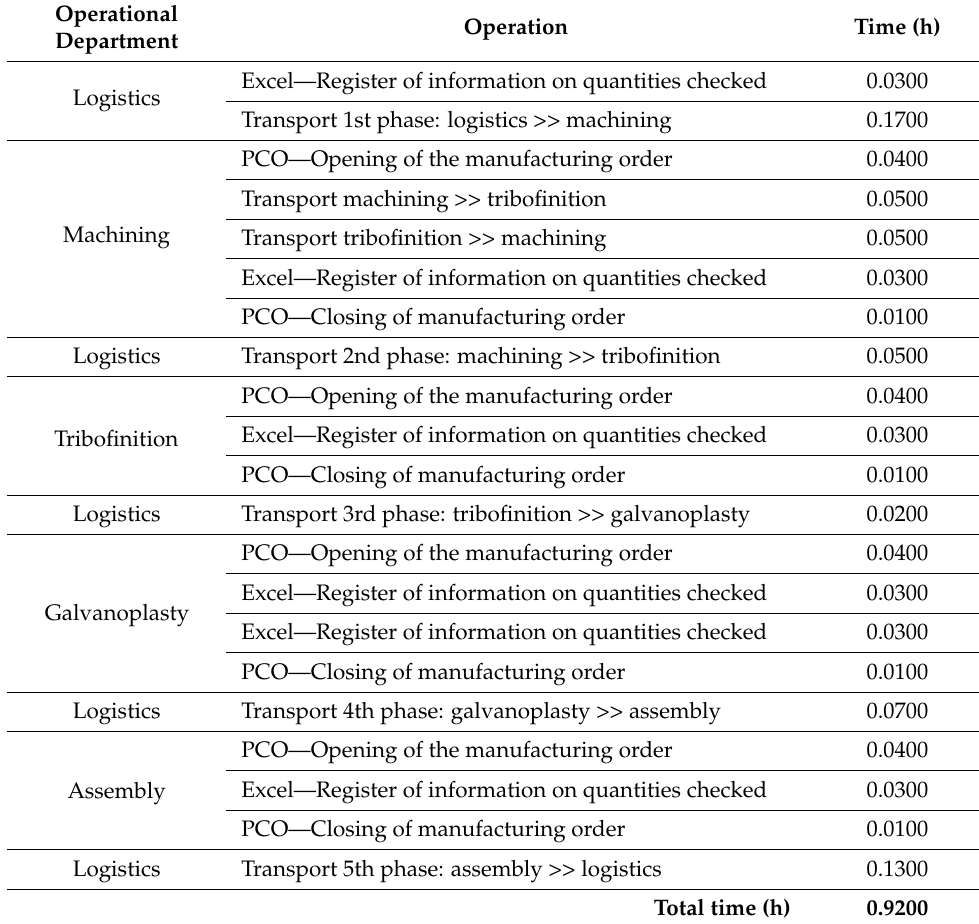
Table 9. Non-value operation times of the production flow for the part “ring”.